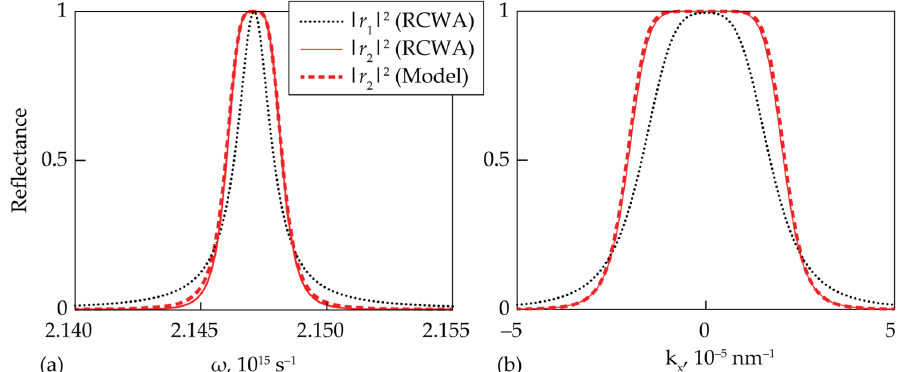
Figure 3. Rigorously calculated reflectance of the stacked structure satisfying the condition (17) vs. angular frequency at k x = 0 ( a ) and vs. tangential wavevector component at ω = Re ω p 1 ( b ) (solid lines); squared absolute values of the “model” reflectance | r 2 ( k x = 0, ω ) | 2 of Equation (20) ( a ) and (cid:12) (cid:17)(cid:12) (cid:16) 2 (cid:12) (cid:12) k x , ω = Re ω p1 of Equation (22) ( b ) of the corresponding Butterworth filters (dashed red lines). (cid:12) r 2 (cid:12) Dotted lines show the reflectance of the single resonant grating calculated using